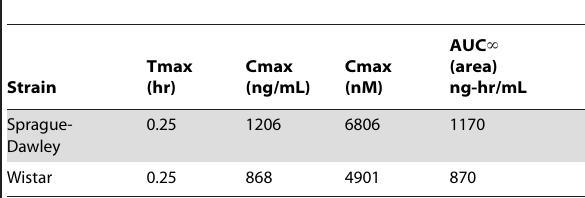
Figure 5. Mean (N=3, ± SEM) plasma levels of 4-MMC up to 6 hrs after administration of 5.6 mg/kg 4-MMC, s.c.